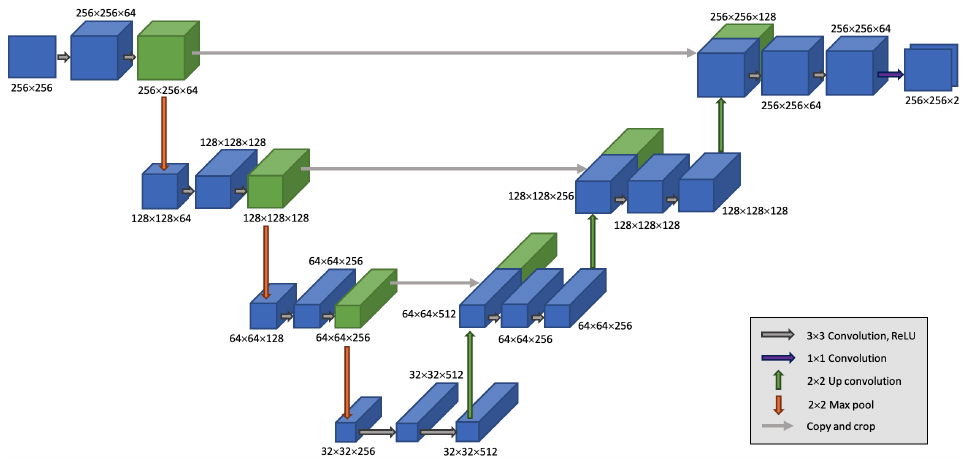
Figure 3. U-Net architecture with a depth of 3 and lowest resolution of 32 × 32